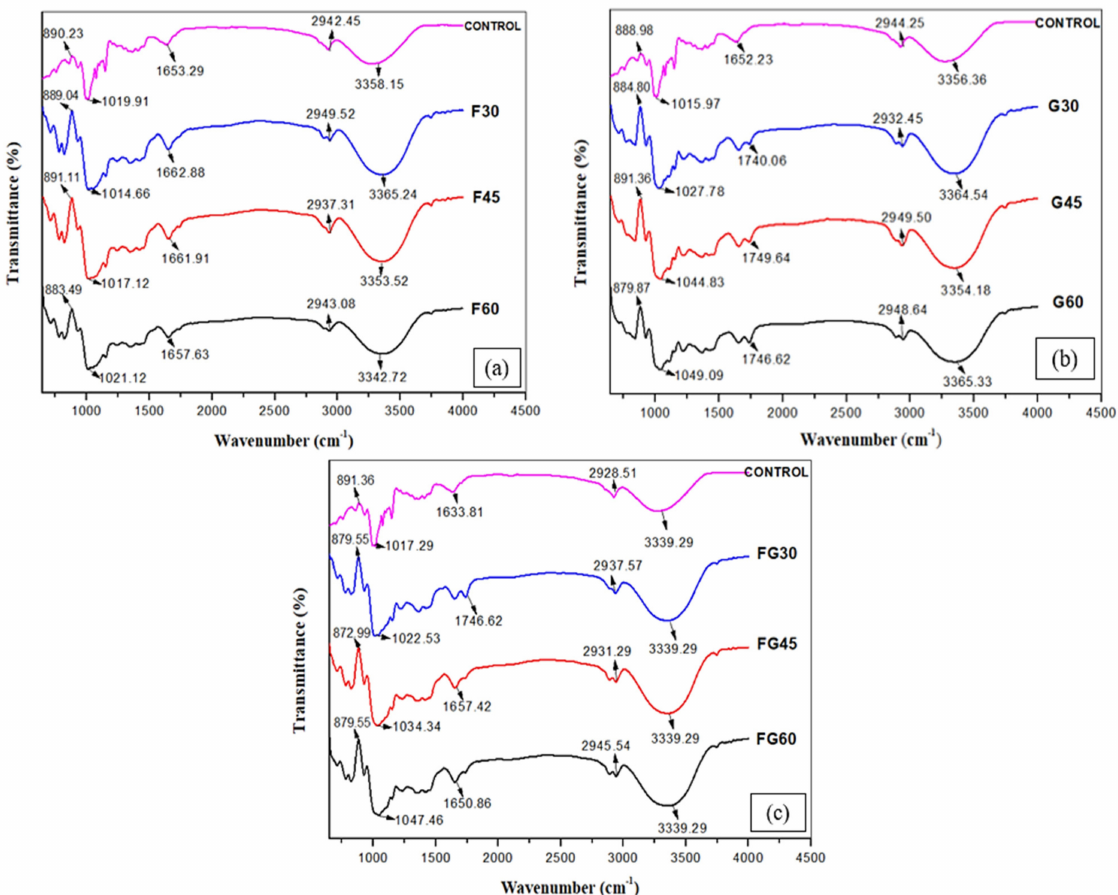
Figure 5. FTIR spectra of CS films with various plasticizers at different concentrations; ( a ) F-plasticized film, ( b ) G-plasticized film, ( c ) FG-plasticized